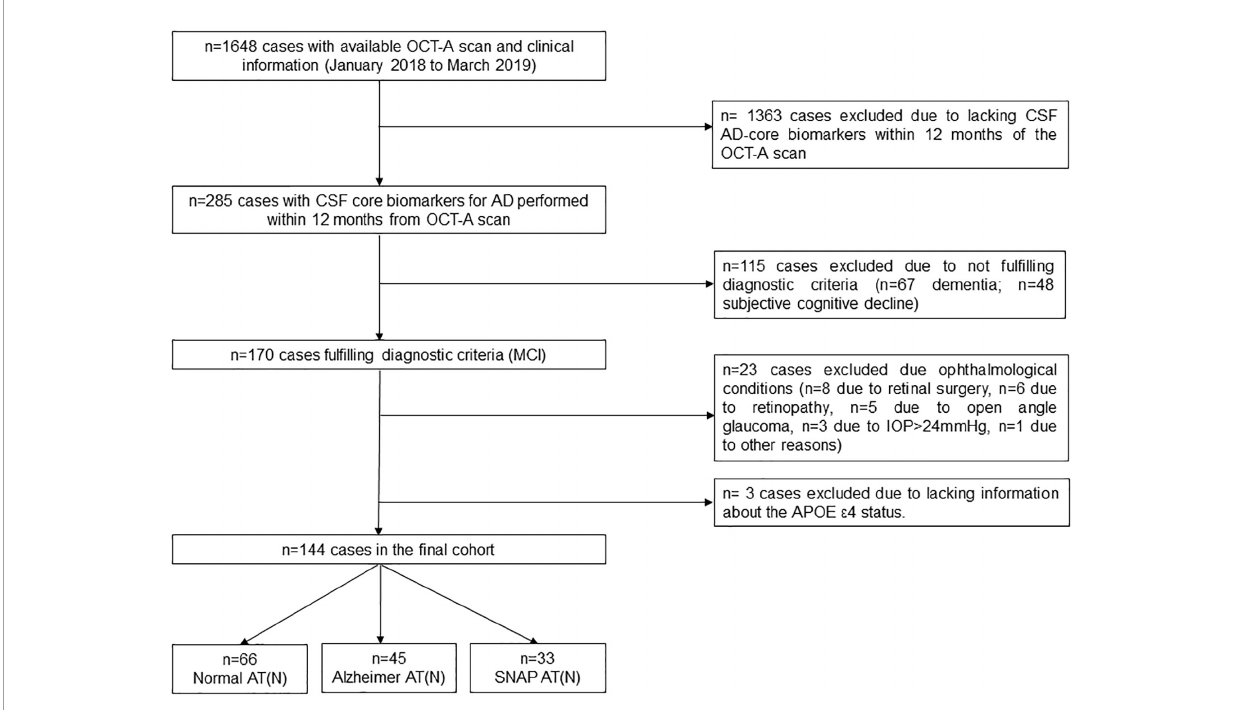
FIGURE1 Participants’ selection algorithm. AD, Alzheimer’s disease; APOE , apolipoprotein E; OCT-A, optical coherence tomography-angiography; CSF, cerebrospinal fluid; IOP, intraocular pressure; MCI, mild cognitive impairment; SNAP, suspected non-Alzheimer pathology; VD, vessel density.